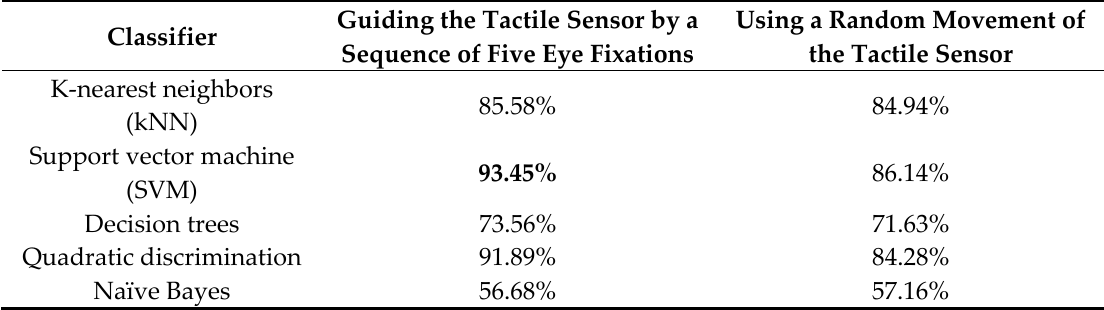
Table 1. Object classification